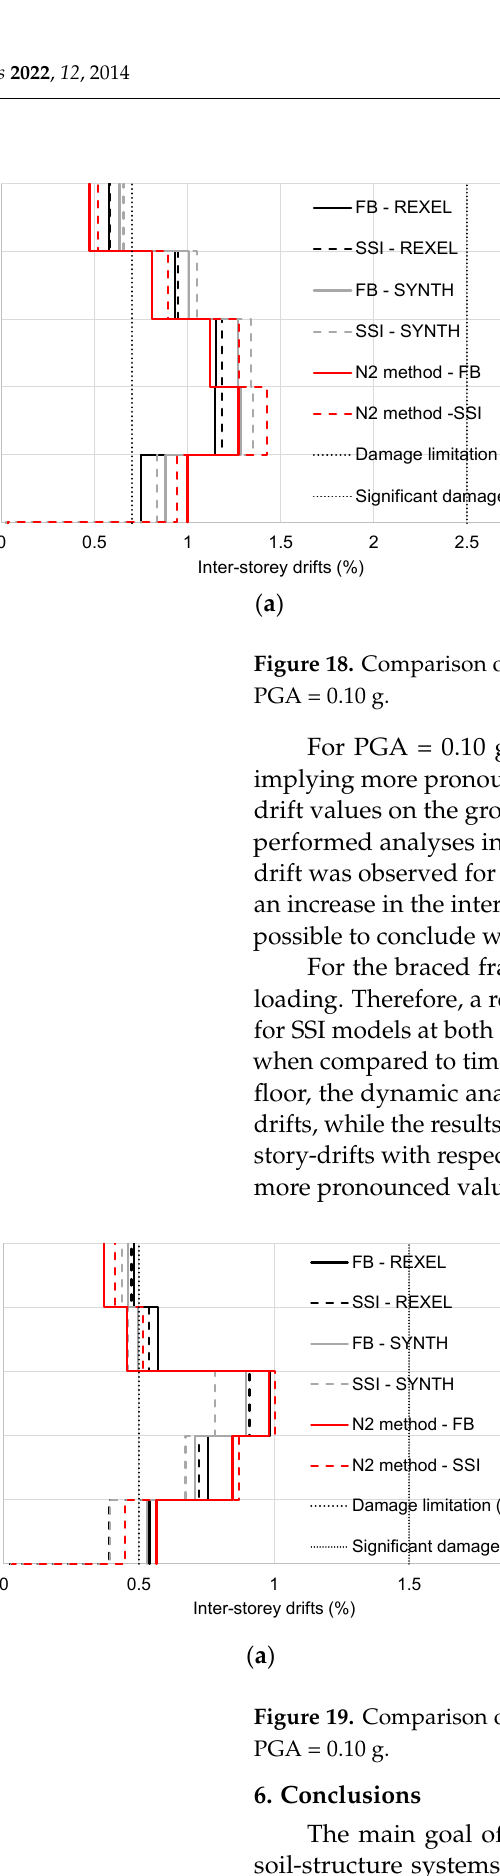
Figure 19. Comparison of inter-story drifts for: ( a ) Y-direction, PGA = 0.215 g and ( b ) Y-direction, PGA = 0.10 g.